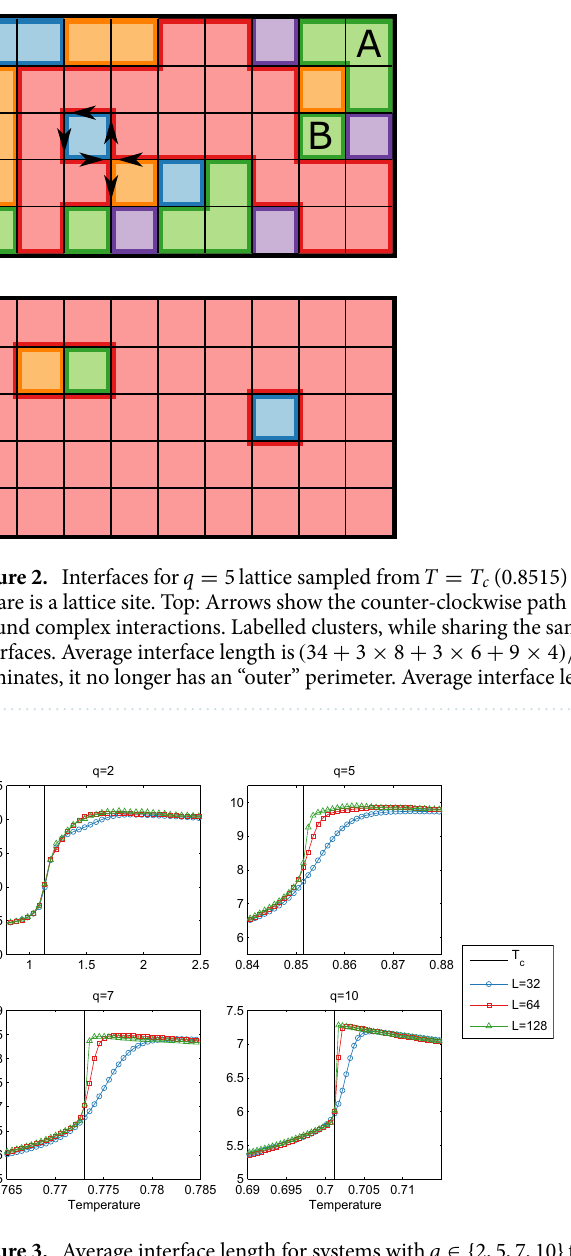
Figure 3. Average interface length for systems with q peak location mimics the behaviour of the G peak in all systems: the first-order cases, q T c as the system becomes more strongly first order (increased q , L ), while the second-order peak q stable above the phase transition. Note the factor of two difference in temperature for q simply due to a slight difference in definition of site energy (i.e., E ij ), with no further side